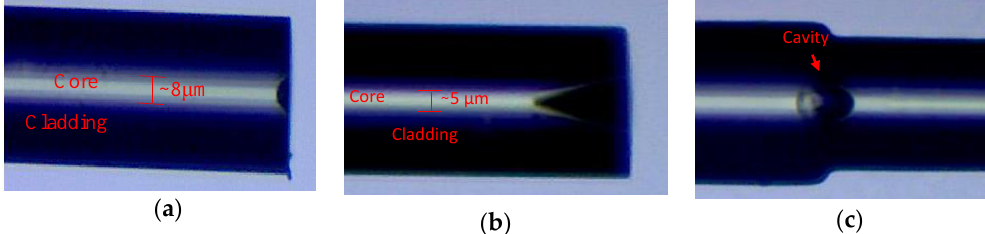
Figure 3. Microscopic photos of half cavity at the fiber tip of ( a ) SMF, ( b ) TCF and ( c ) closed air cavity in the fiber core.